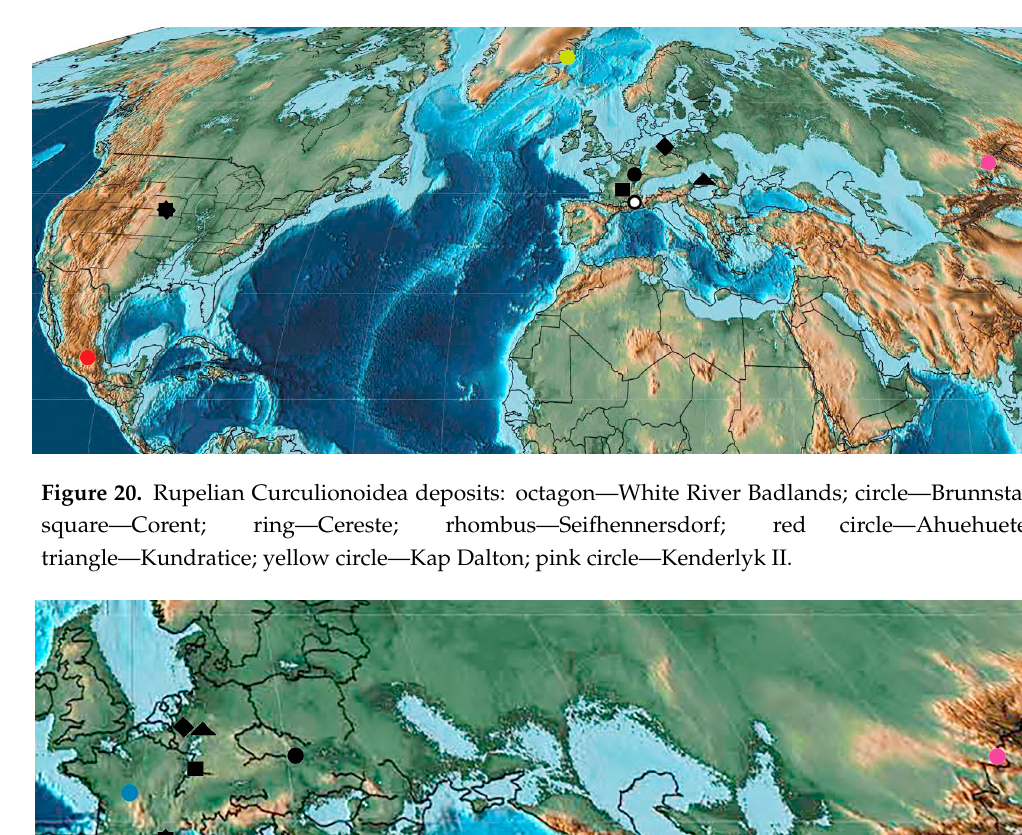
Figure 20. Rupelian Curculionoidea deposits: octagon—White River Badlands; circle—Brunnstatt; square—Corent; ring—Cereste; rhombus—Seifhennersdorf; red circle—Ahuehuetes; triangle—Kundratice; yellow circle—Kap Dalton; pink circle—Kenderlyk II.